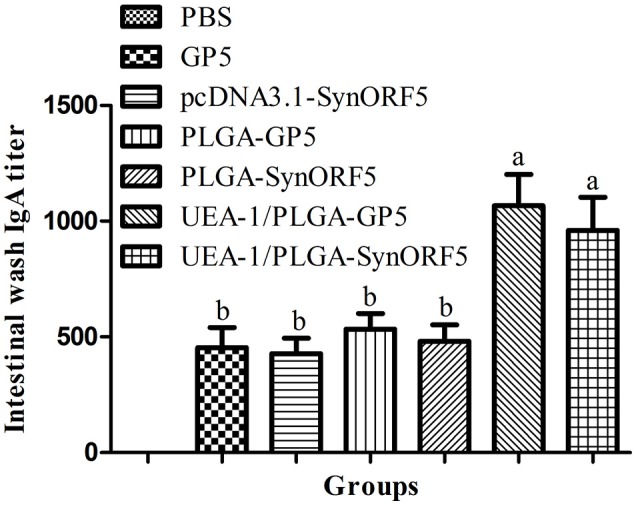
Mucosal immune response in mice induced by different PRRSV vaccine formulations. Female BALB/c mice (6–8 weeks old, n = 7 in each group) were orally immunized with 100 μL PBS, pcDNA3.1-SynORF5, GP5, PLGA-SynORF5, PLGA-GP5, UEA-1/PLGA-SynORF5, or UEA-1/PLGA-GP5 at 0 and 2 weeks. Intestinal samples were collected at 42 dpi to determine the GP5-specific IgA antibody by ELISA. Data represent the mean ± s.e.m. for 7 mice per group. Columns with different letters differ significantly (P < 0.05).